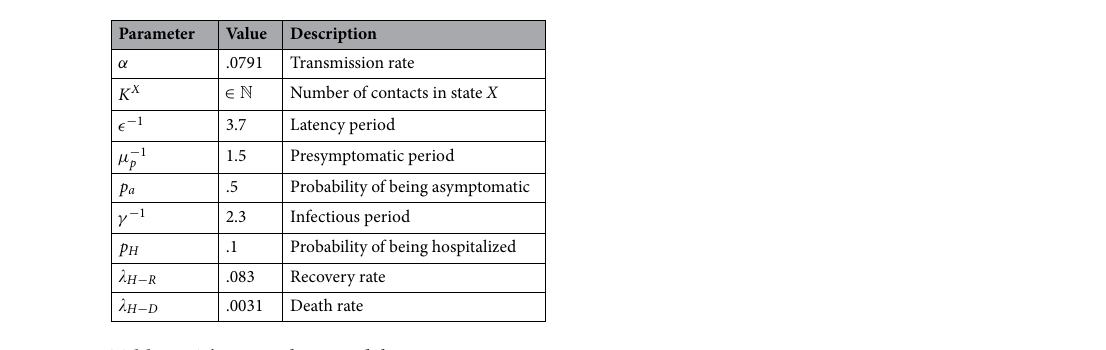
Table 2. The spreading model parameters